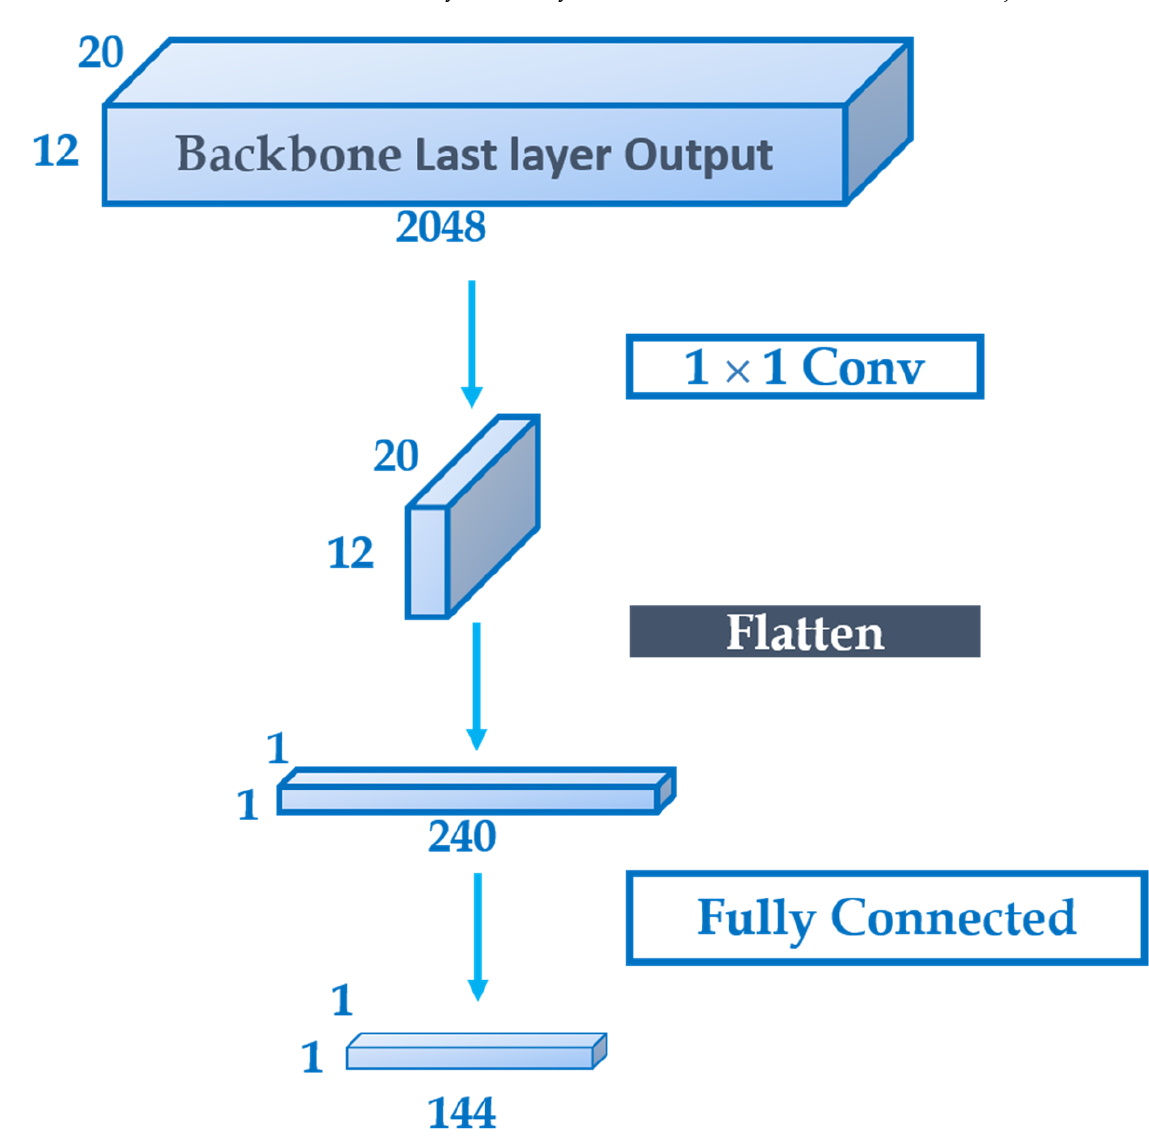
Figure 7. The proposed vanishing point subnet architecture.